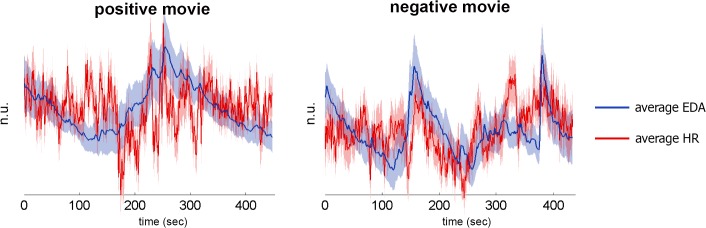
Average autonomic response time-courses elicited by positive and negative movies.Figure presents normalized EDA (blue) and HR (red) response time-courses (2HZ), averaged across participants. Shaded areas represent standard errors.